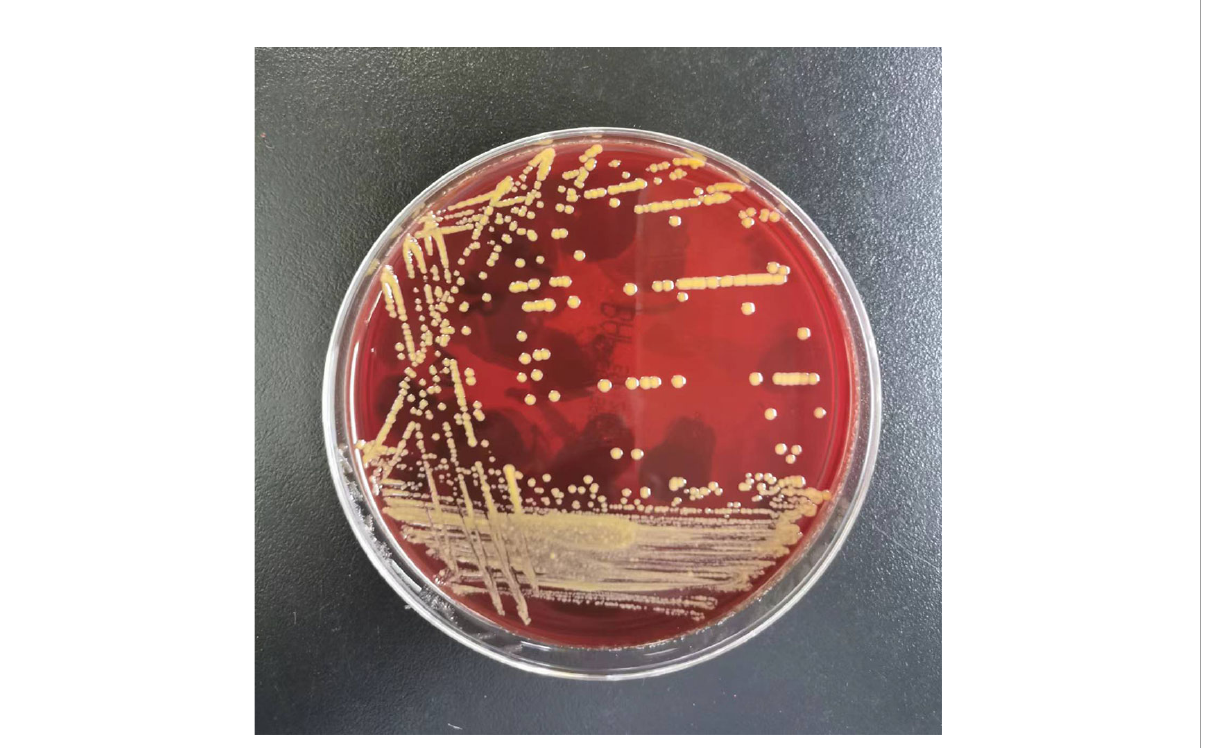
FIGURE 3 Mycobacterium neoaurum growth on blood plate. Note the smooth daffodil yellow appearance of